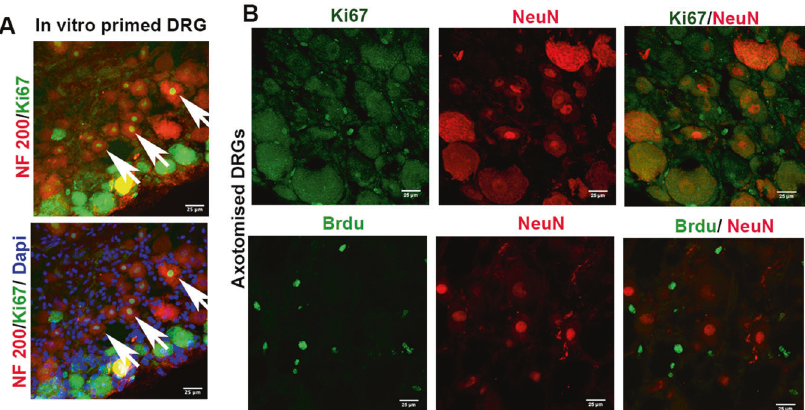
Fig. 2 Sensory neurons attempt cell cycle entry. A Sections of adult rat DRGs incubated in vitro for three days ( in vitro priming) in DMEM/ F12/FBS media show Ki67 expression in neurons. Arrows indicate nuclear expression of Ki67 and its co-localization with the nuclear stain dapi [scale bar, 25 µm]. B Sections of DRGs from sciatic nerve injured (transection injury) adult rats do not show Ki67 expression or Brdu incorporation in neurons after 3 days of injury, evident by lack of co-staining of NeuN with Ki67 or Brdu [scale bar, 25